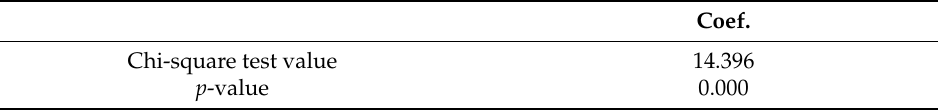
Table 3. Hausman specification